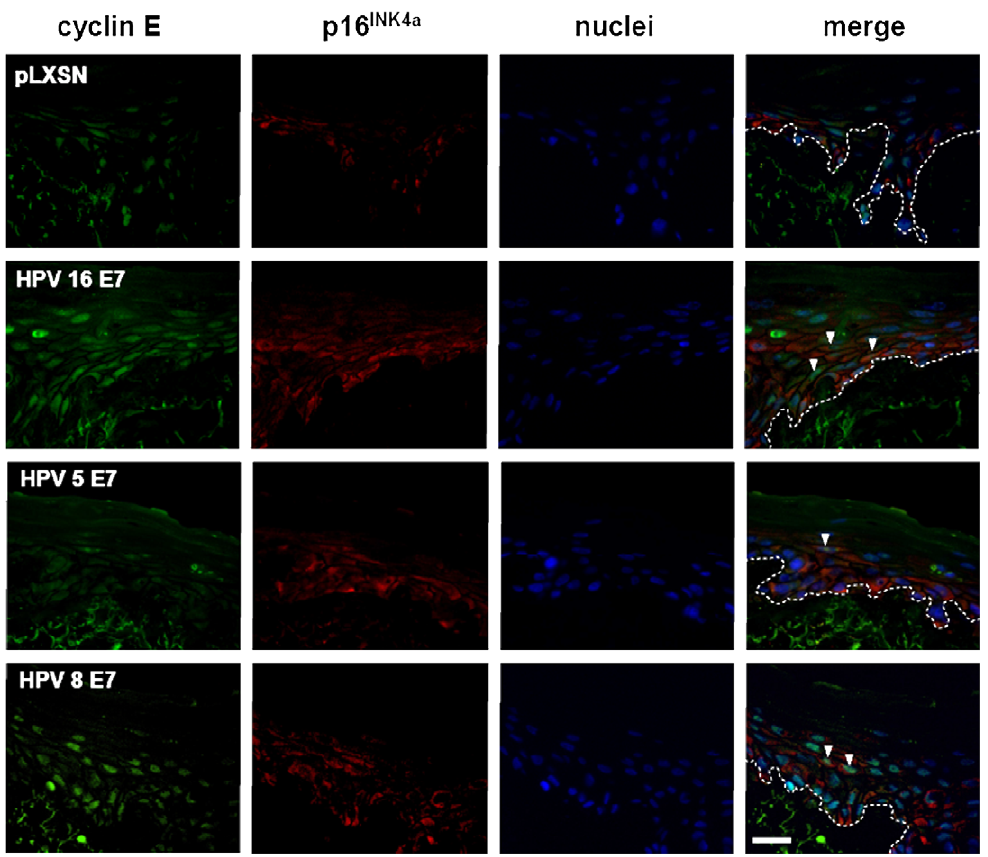
Fig. 5. Suprabasal co-localisation of cyclin E and p16 INK4a in organotypic skin cultures infected with E7 of HPV 5, or 8. The presence of cyclin E (green) and p16 INK4a (red) was examined by double staining of paraffin embedded organotypic skin culture sections. The nuclei were stained with DAPI (blue). Four representative examples of skin cultures infected with E7 of HPV 5 or 8 ( β -PV) or HPV 16 ( α -PV, positive control) or the empty vector pLXSN (negative control) are shown. Co-localisation of p16 INK4a and the cell cycle marker cyclin E within the same keratinocytes at the suprabasal layer of HPV 5 and HPV 8 are shown indicated by white arrows. Original magnification was × 400. Scale bar: 100 µm. (The colors are visible in the online version of the